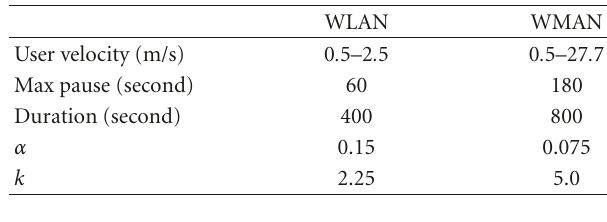
Table 2: Parameters for UMD mechanism and random waypoint mobility model.